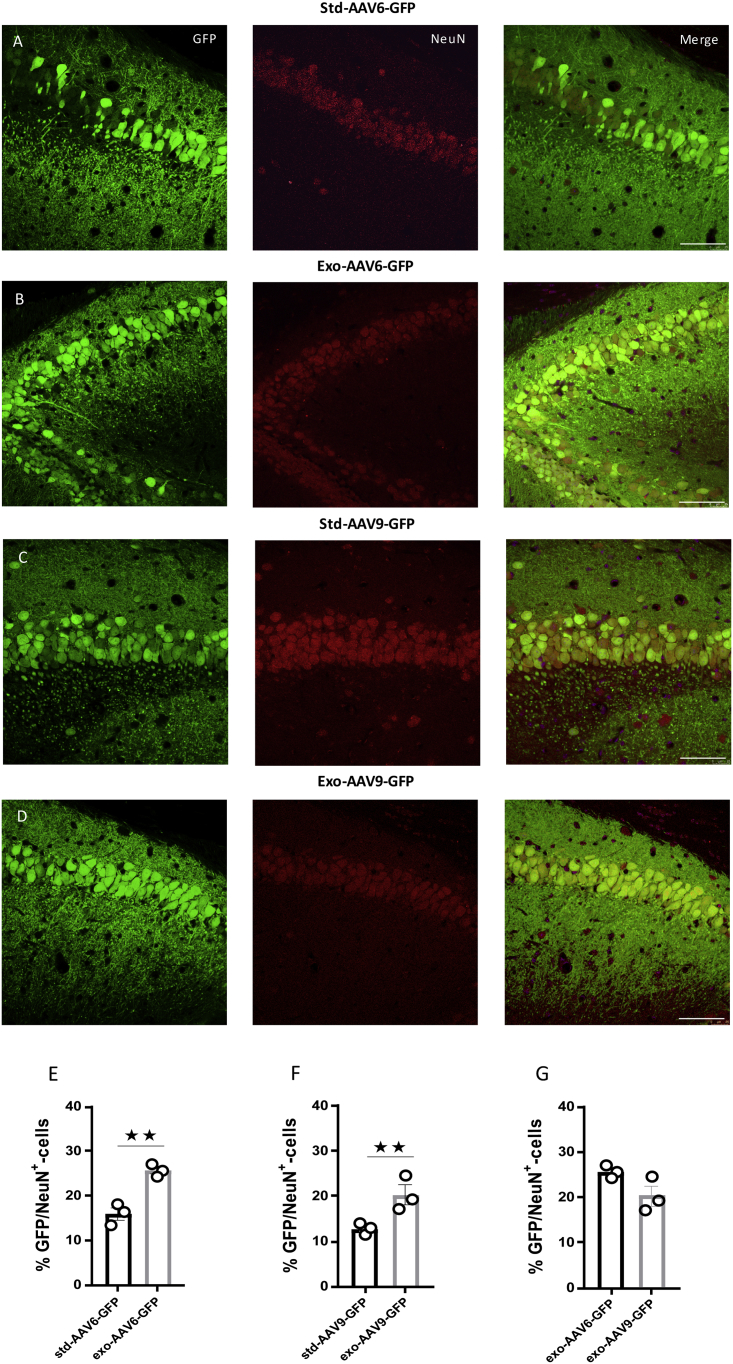
Neurons Are Preferentially Targeted by Exosome-Conjugated AAVs(A and B) Co-localization of GFP (green) with the neuronal marker NeuN (red) expressed by (A) std-AAV6 and (B) exo-AAV6 vectors. (C and D) Co-localization of GFP (green) with the neuronal marker NeuN (red) expressed by (C) std-AAV9 and (D) exo-AAV9 vectors. Slices were stained for neuronal marker NeuN at 3 months after bilateral injection into hippocampus. Images were taken using a Leica SP8 confocal microscope at 40× magnification. The merge image of both channels (GFP-NeuN) is shown on the right panel. Scale bar 20 μm. (E and F) Graphs represent GFP-NeuN-positive cells quantified and expressed as a percentage of total GFP-positive cells between (E) std-AAV6 and exo-AAV6 and (F) std-AAV9 and exo-AAV9. A preferential target neuronal was observed in exo-AAV6 and exo-AAV9 compared with std-AAV6 and std-AAV9 (n = 12; p = 0.0028; p = 0.0019). (G) No difference between exo-AAV6 and exo-AAV9 vectors. The data were analyzed by two-way ANOVA with Tukey post hoc test. Data are presented as mean ± SEM. **p < 0.01.